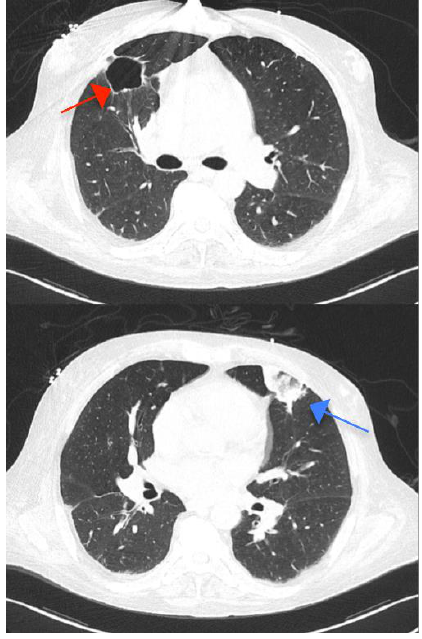
Figure 5. Thoracic computed tomography revealing one of the four cavities in the right upper lobe (red arrow) and one triangular consolidation in the left superior lobe, raising the suspicion of tuberculosis reactivation (blue arrow).